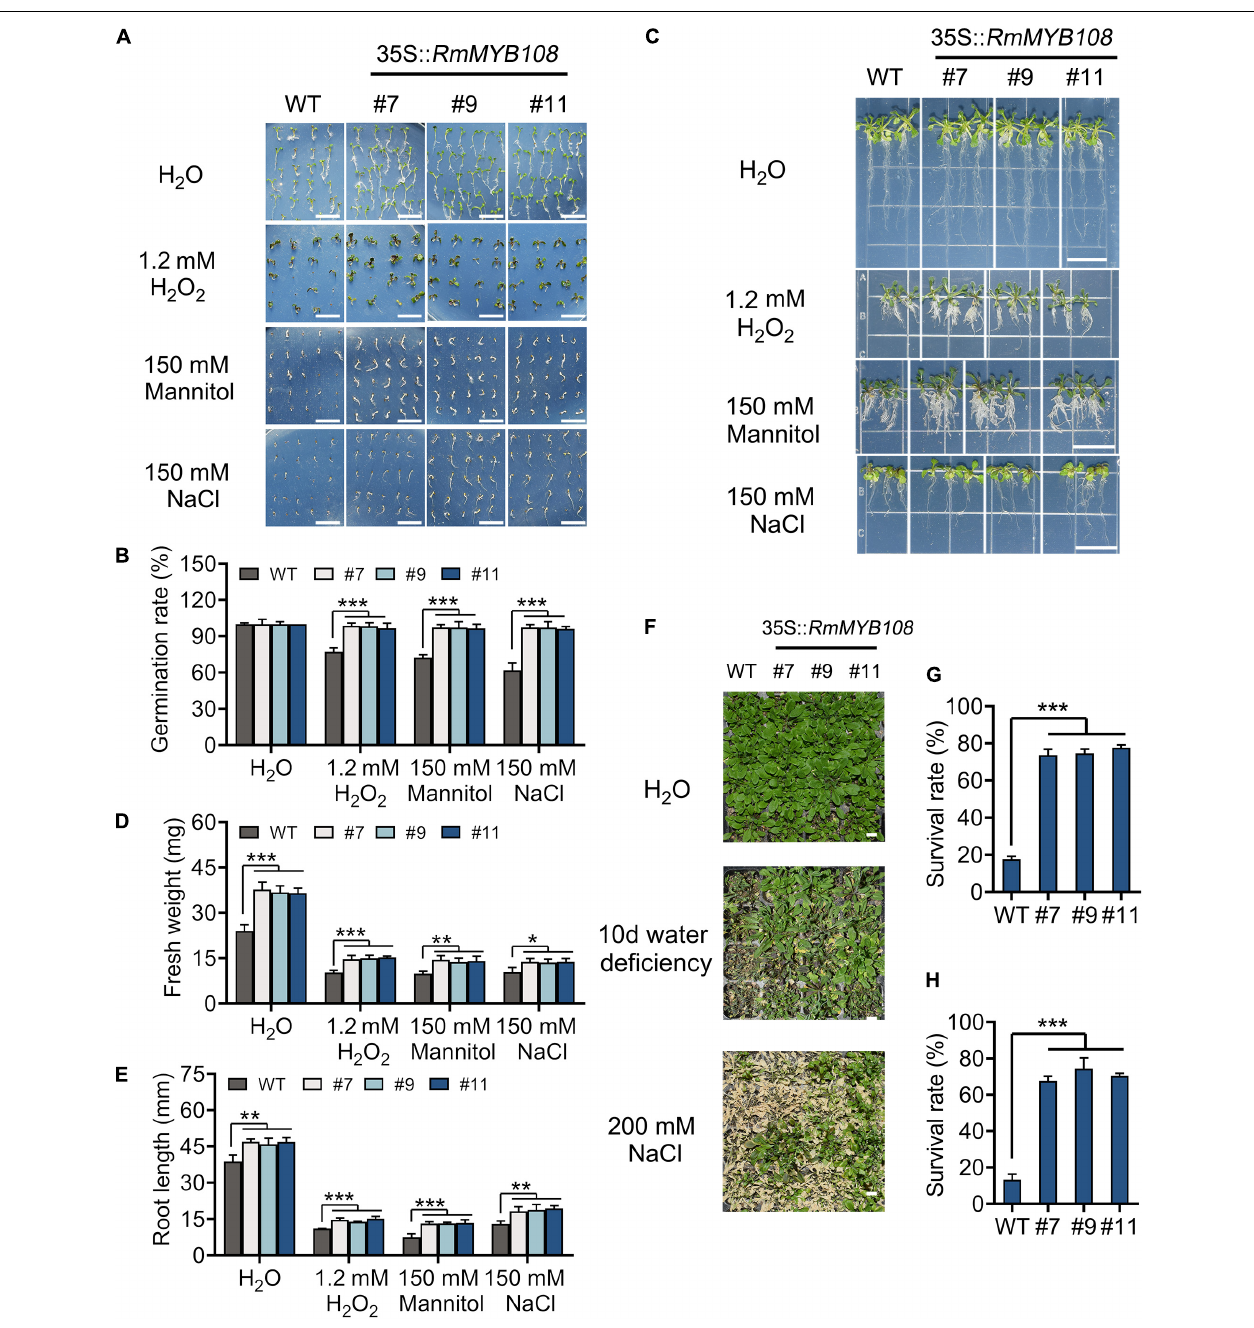
FIGURE 8 | Effects of stress due to simulated oxidation, drought, and salt on plant growth. Seed germination phenotype (A) and germination rate (B) , seedlings growth (C) , fresh weight (D) , and root length (E) of WT and OE lines were observed and measured under deionized water (H 2 O), 1.2 mM H 2 O 2 , 150 mM mannitol, and 150 mM NaCl, respectively. The 20-days WT and #7, #9, and #11 were not watered or watered with 200 mM NaCl for 10 days (F) ; the survival rate (G,H) were calculated and revealed that RmMYB108 enhanced plant tolerance against stress due to dehydration and oxidation. Data represent mean value + SD ( n = 30). * p < 0.05; ** p < 0.01; *** p < 0.001 in